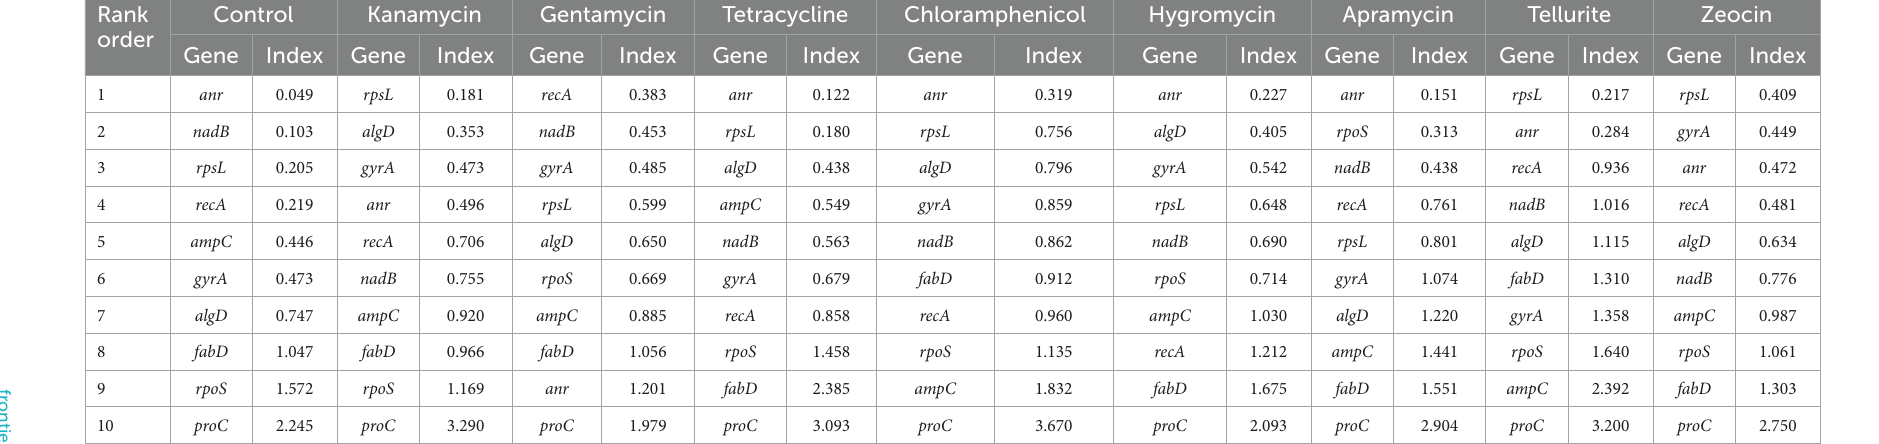
TABLE 3 Expression stability of seleceted Pseudomonas aeruginosa housekeeping genes calculated by NormFinder under different antibiotic stress. Rank order